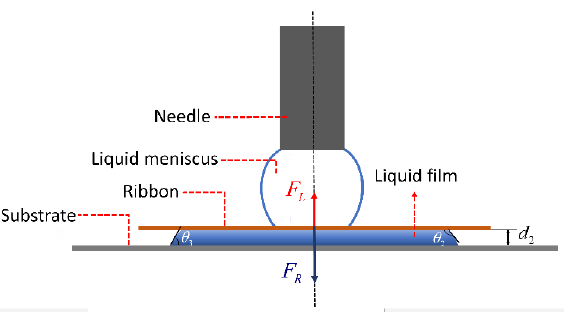
Figure 4. Force illustration of releasing a ribbon.